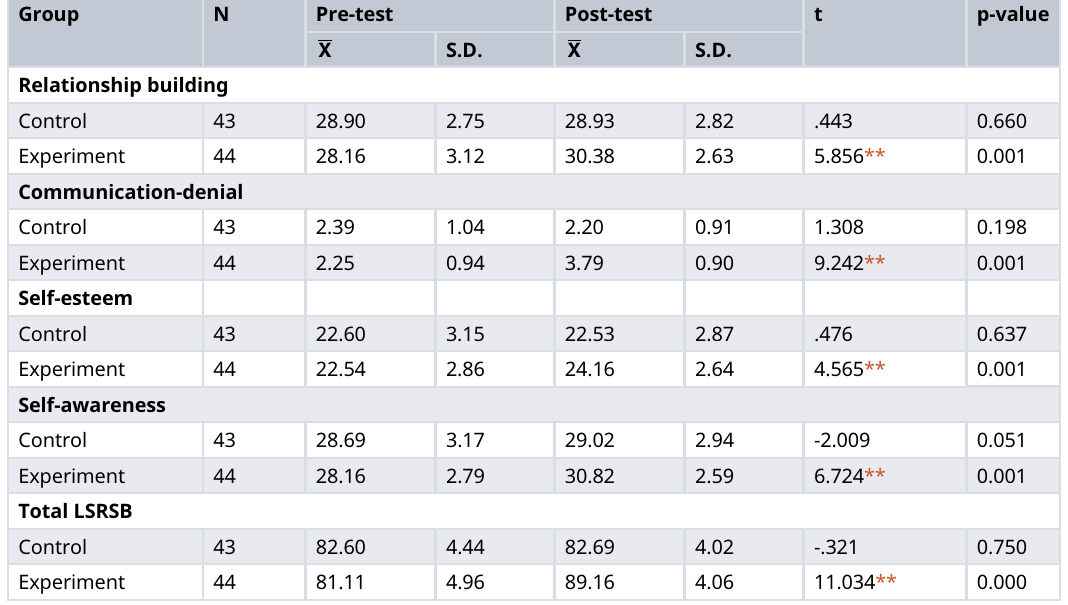
Table 1. Mean and paired t-test statistics of the four variables of the control group and the experimental group.